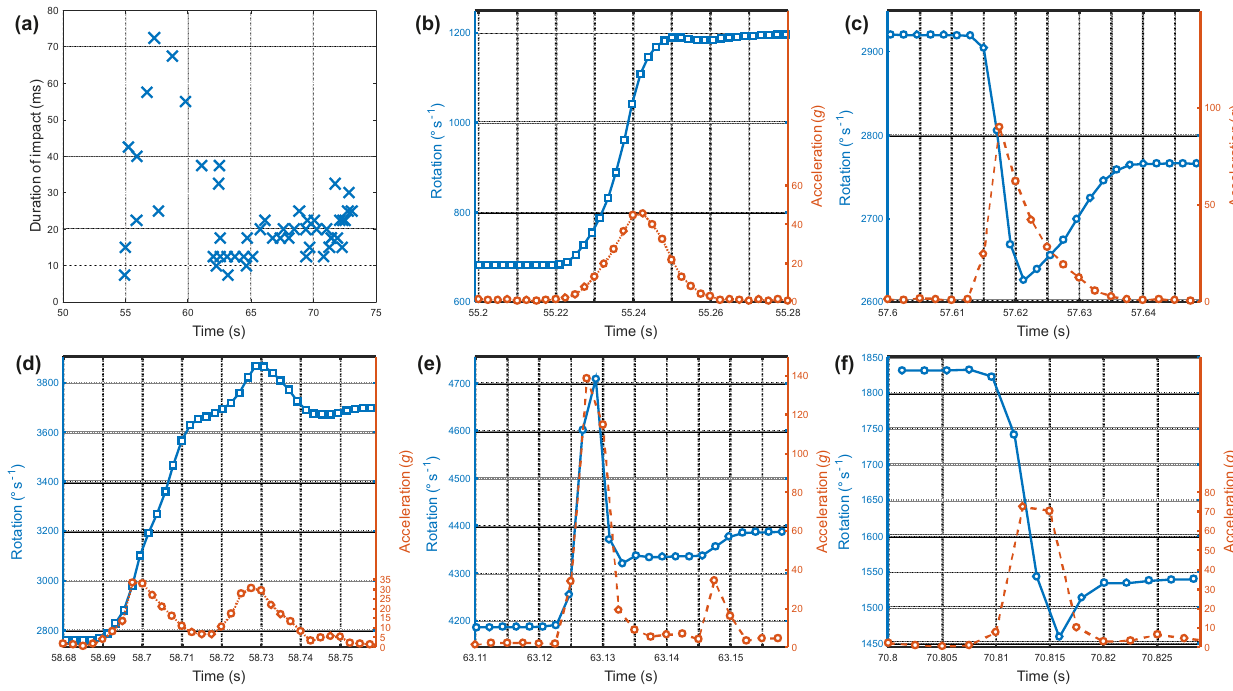
Figure 2. (a) Duration of ground contacts. (b) Absolute rotational and acceleration values for the ground contact at 55.24s lasting 42ms, (c) at 57.62s lasting 28ms, (d) at 58.72s lasting 68ms, (e) a double contact from 63.13s onward lasting 13ms and 8ms, (f) and at 70.81s lasting 13ms. The error on individual measurements is smaller than the plotted marker